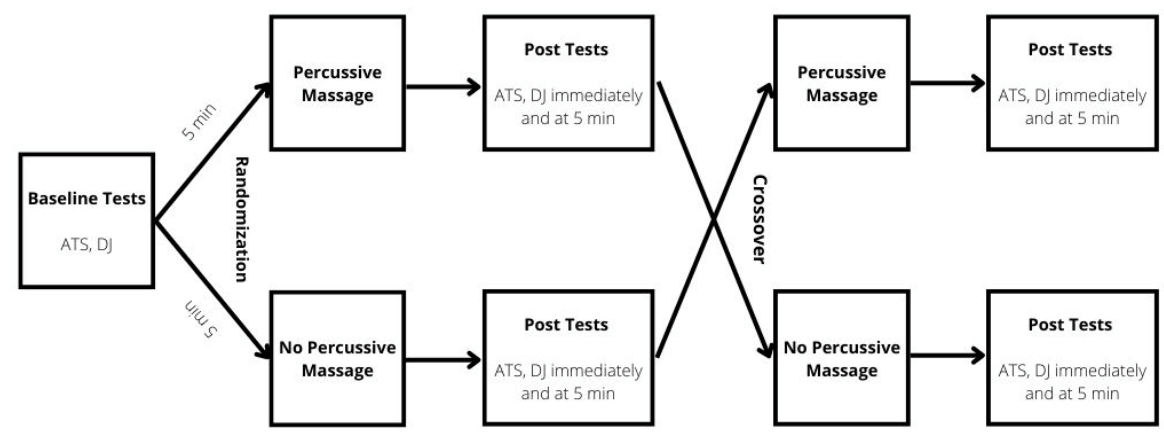
Figure 1. Study design flowchart. ATS–Achilles tendon stiffness; DJ–drop jump.